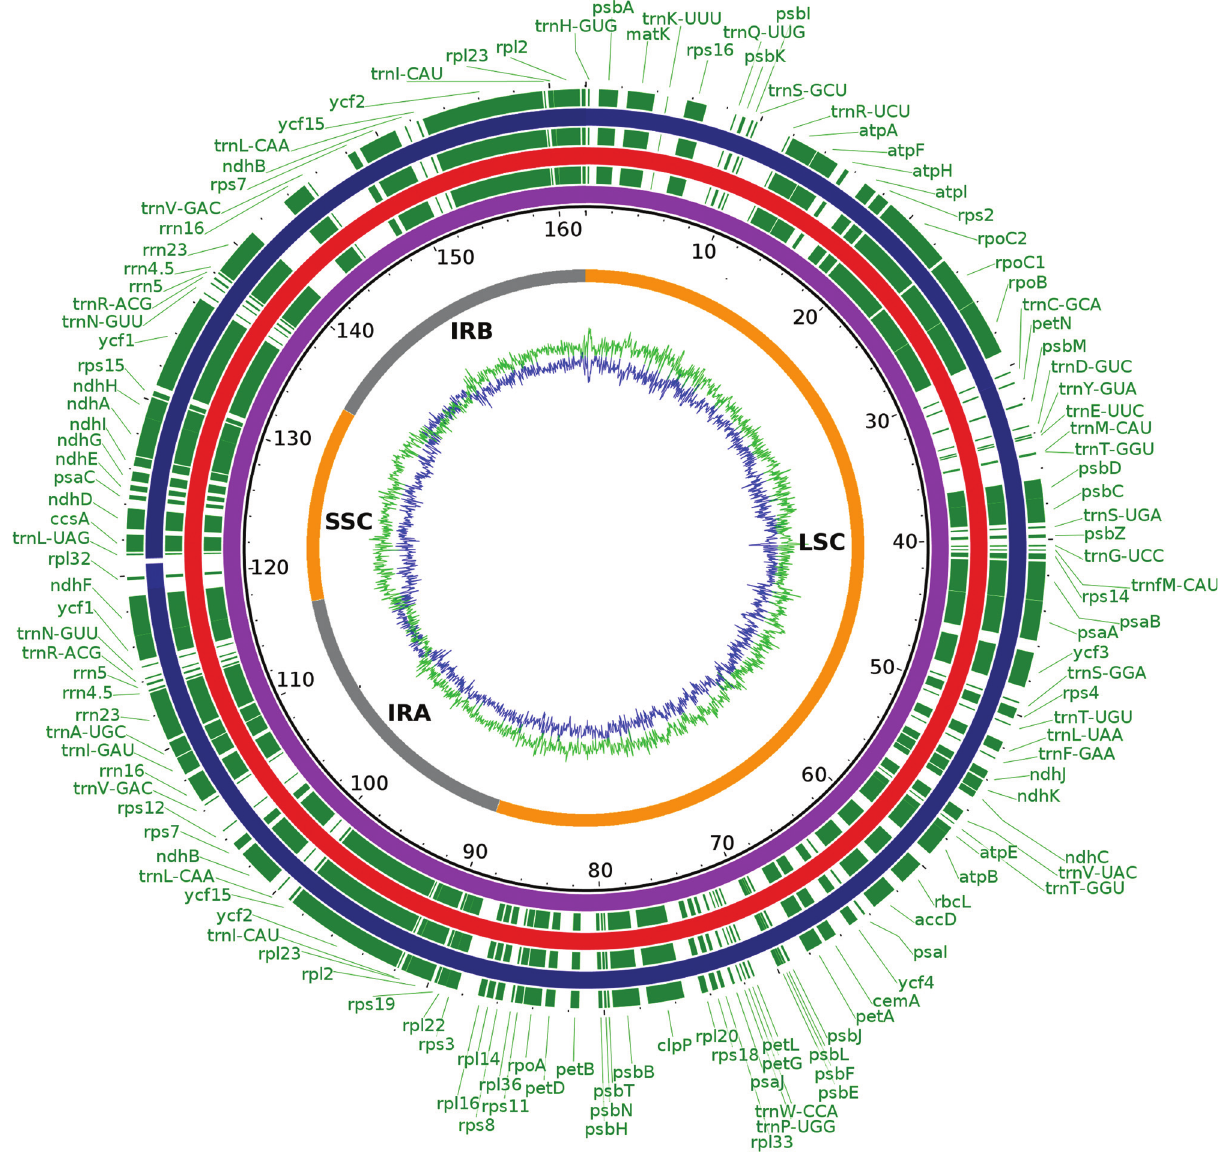
Figure 1 - Complete gene map of Spondias chloroplast genomes. Gene annotations are represented in green. The chloroplast genomes are represented in purple ( S. tuberosa ), red ( S. bahiensis ), and blue ( S. mombin ). LSC: large single copy region; SSC: small single copy region; IR: inverted repeat. The green ring represents the A+T contents and the blue ring indicates C+G contents. The numbers near to S. tuberosa (purple circle) represent the nucleotide positions (in